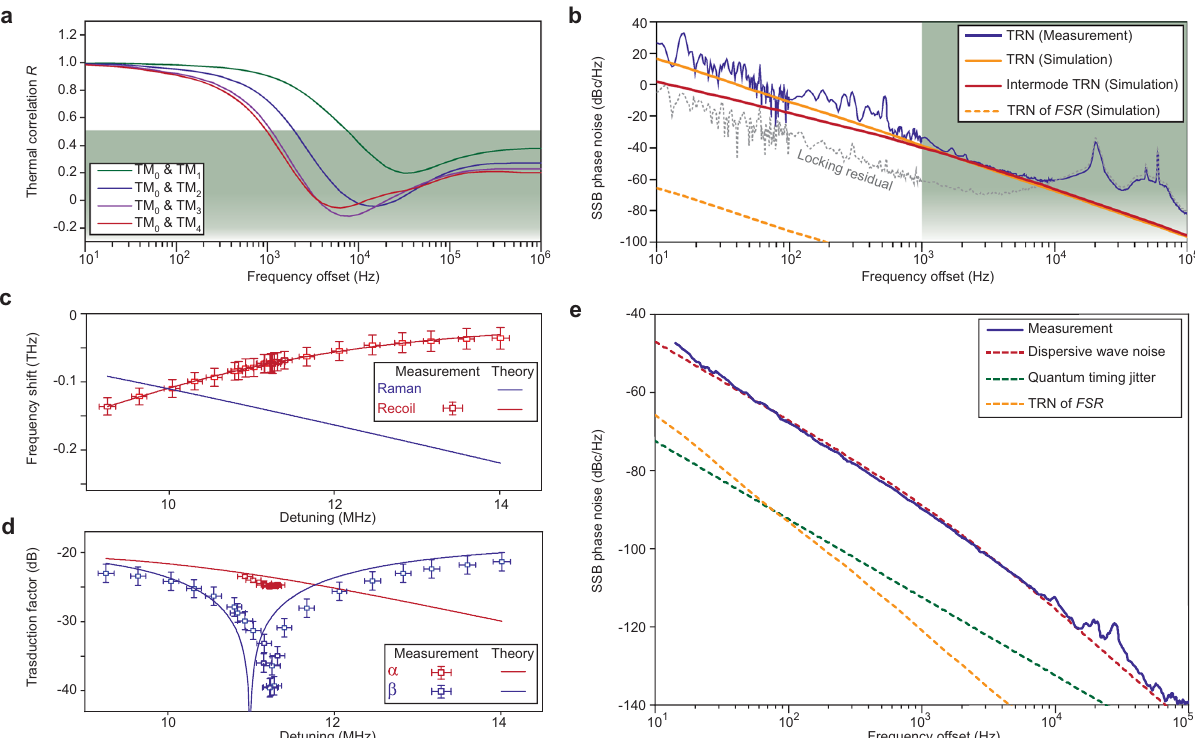
Fig. 5 Intermode thermal noise (between dispersive wave and soliton modes) and its impact on soliton repetition rate. a Simulated temperature correlation R between transverse mode volumes versus frequency of thermal fl uctuation. Speci fi c transverse mode pairs are indicated in the legend. Green region corresponds to R < 0.5. b Measured and simulated single-sideband (SSB) TRN of a TM 0 mode. The simulated intermode TRN between TM 0 and TM 4 is also displayed. Green region corresponds to R < 0.5 in a . c Contribution of Raman SSFS and dispersive recoil to total spectral center frequency shift of the soliton. The error bar indicates standard deviation, and is contributed from fi tting of the lineshape. d Measured and calculated noise transduction factors. The error bar indicates standard deviation. The error in detuning is contributed by the lineshape fi tting, while the transduction factor error comes from the signal analyzer. e Measured phase noise at maximum quiet point suppression and calculated dispersive-wave induced noise originating from intermode TRN. Quantum timing jitter and thermorefractive noise (TRN) of the FSR are also plotted for